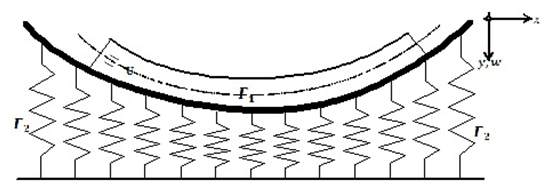
Figure 1. Pipe resting on elastic foundation